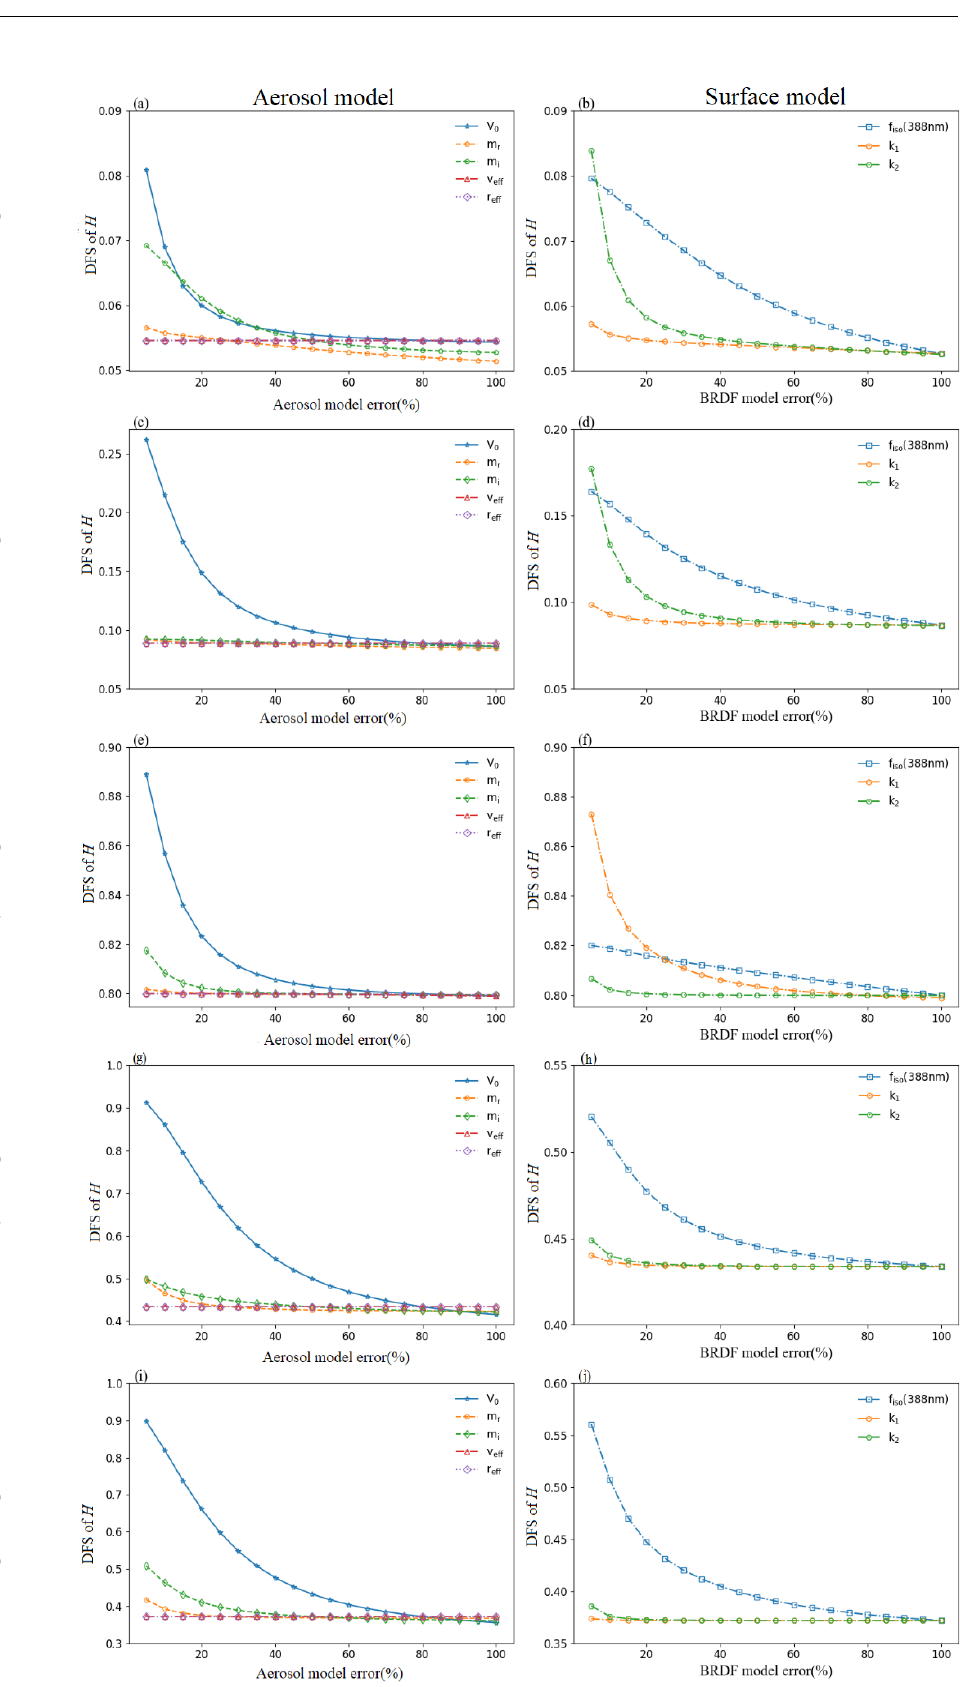
Figure 11. The same as Figure 10, but DFS of H as a function of the coarse aerosol model and surface model parameter errors from 5% to 100% in steps of 5% with AOD = 0.6, in which left ( a , c , e , g , i ) and right panel ( b , d , f , h , j ) corresponds to the aerosol model and surface model respectively.